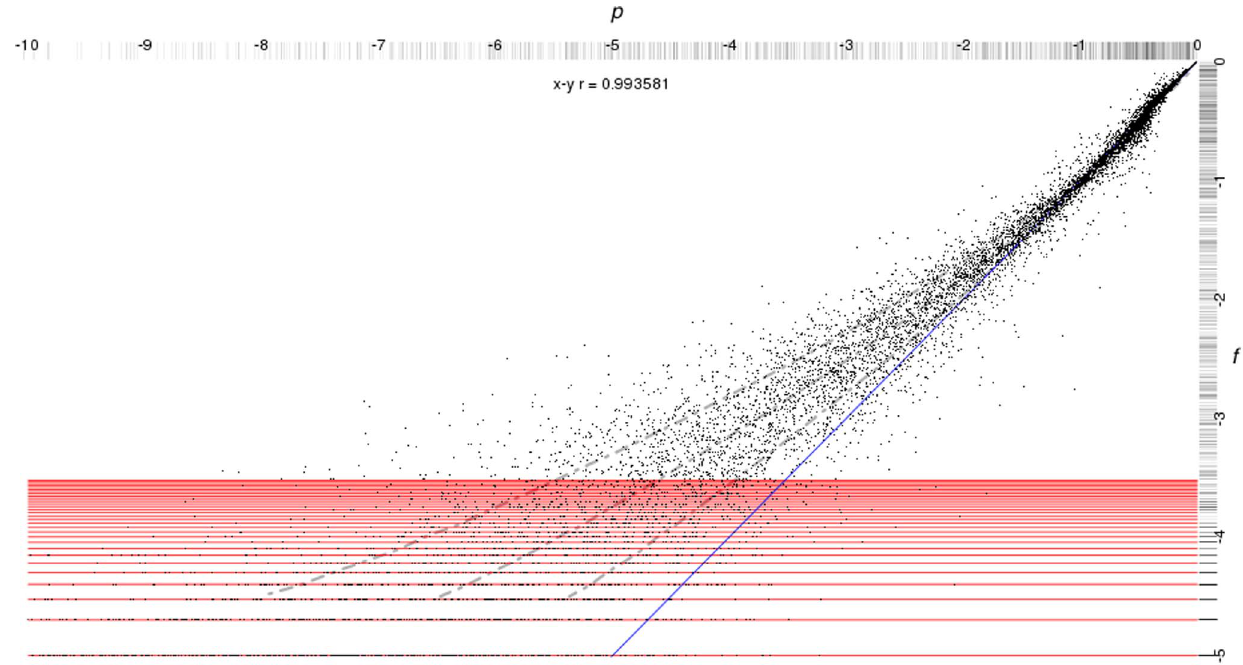
Figure 1. Point Attractor Distribution Correlations. This plot compares the distribution of point attractor number as calculated based on T versus sampled. Each point, with base-10 logarithmic scales, is x , the calculated probability ( p ) of some number ( k ) of point attractors based on T from a particular dynamic D , and y , the sampled frequency ( f ) of that number of point attractors in networks that support D ; or, succinctly: (10 x ,10 y ) ~ ( p k ( T ( D )), f k ( D )) . The plot shows that the T -based distribution is tightly correlated with the sample down to about the 1% level, and then skews low. The plot is annotated with other information: both axes include rug plots to indicate point density, red horizontal lines indicating the 1 to 25 counts out the sample size (the region with visible notable ‘‘lines’’ of sample data), a blue 1-to-1 line for exact correlation, and dashed grey lines indicating the 20%, median, and 80% slices in the p k spread.